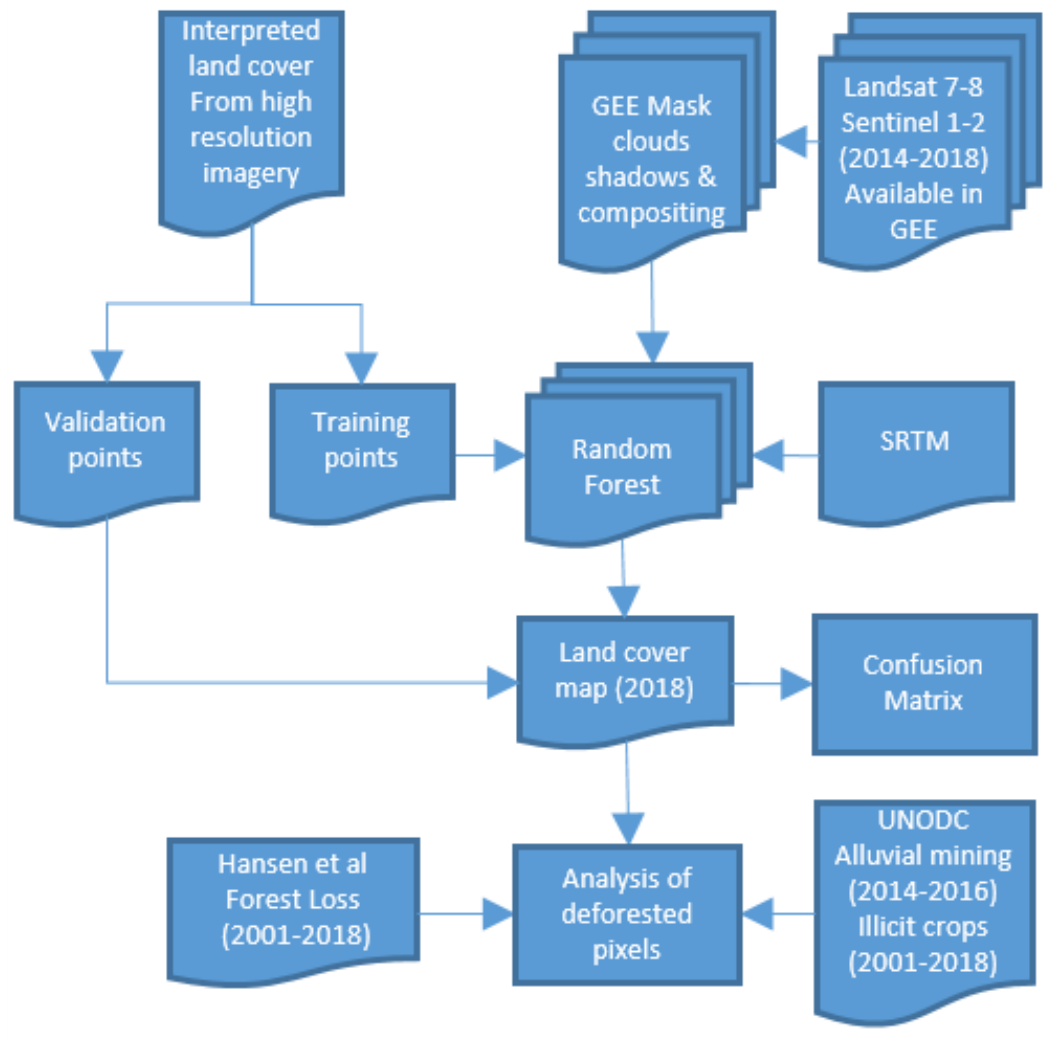
Figure 2. Flowchart of data processing.